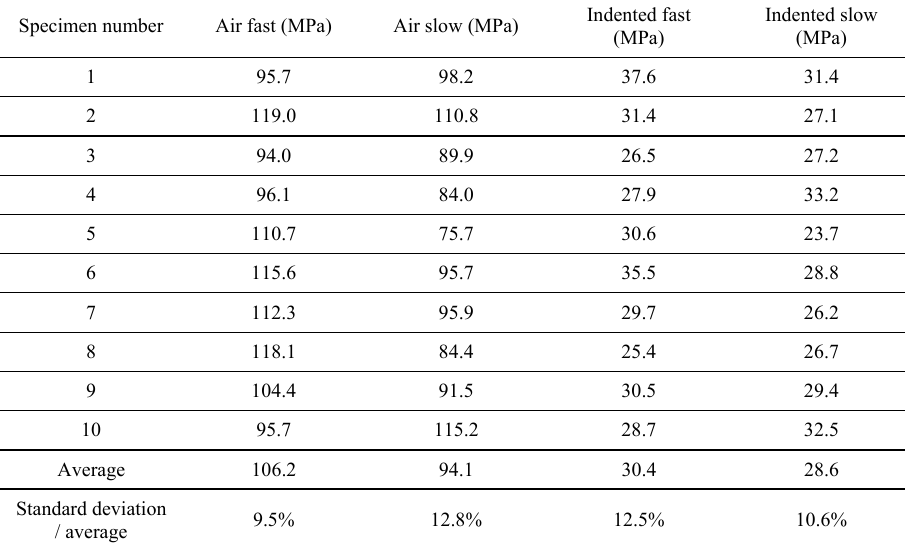
Table 3: Comparison of undamaged and indented bars in